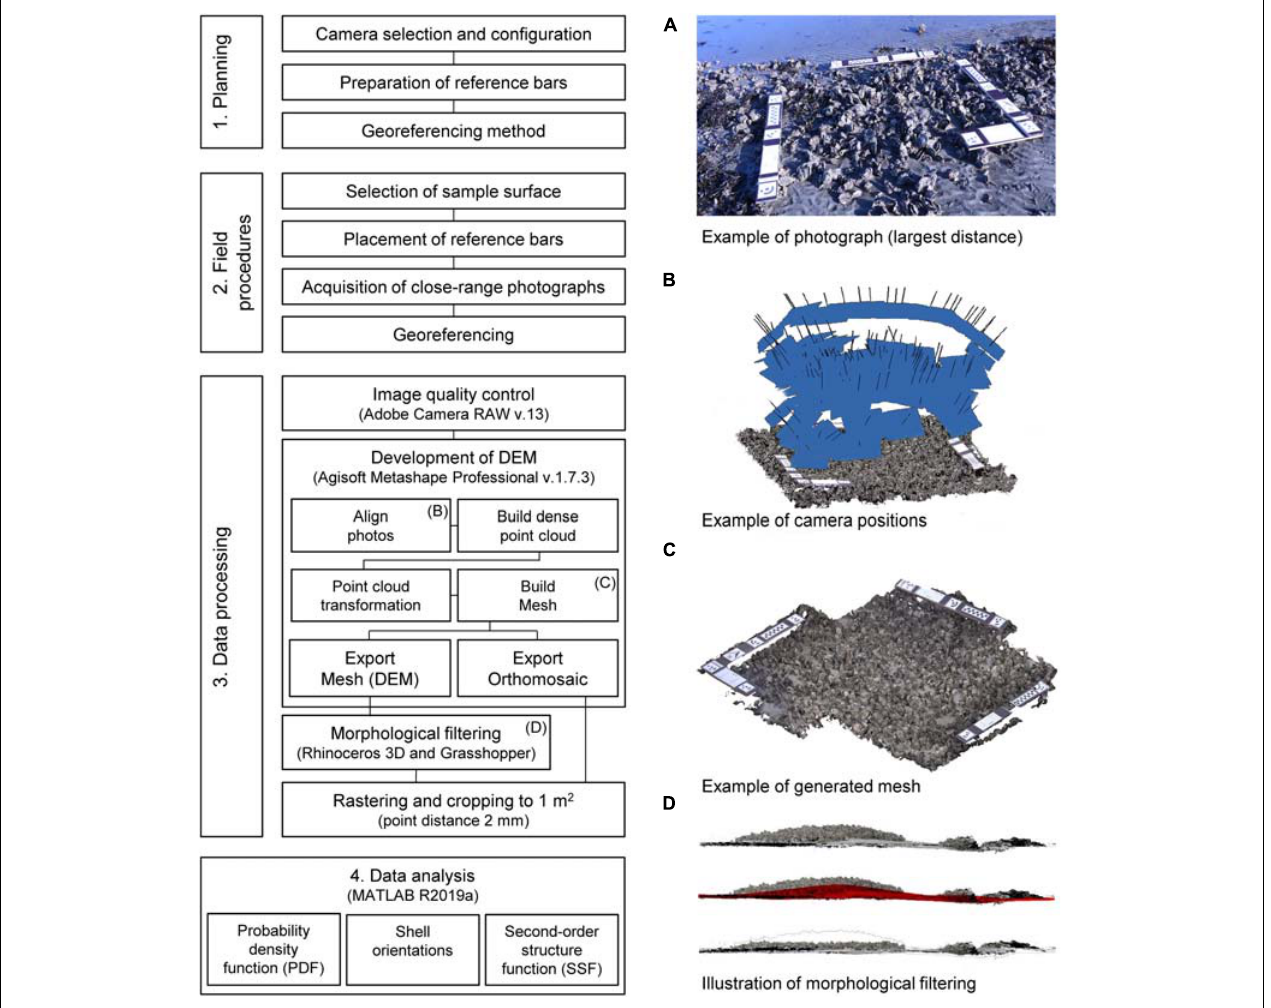
FIGURE 4 | A schematic diagram of the workflow for the development of digital elevation models (DEMs) and subsequent analysis. (A) Example of a photograph used for the SfM photogrammetry (largest distance). (B) Illustration of the camera positions in Agisoft Metashape. The blue patch and black lines illustrate the position of the camera and their orientations. (C) Example of a generated mesh including the reference bars before cropping. (D) Illustration of the morphological filtering. The NURBS surface is illustrated in red.